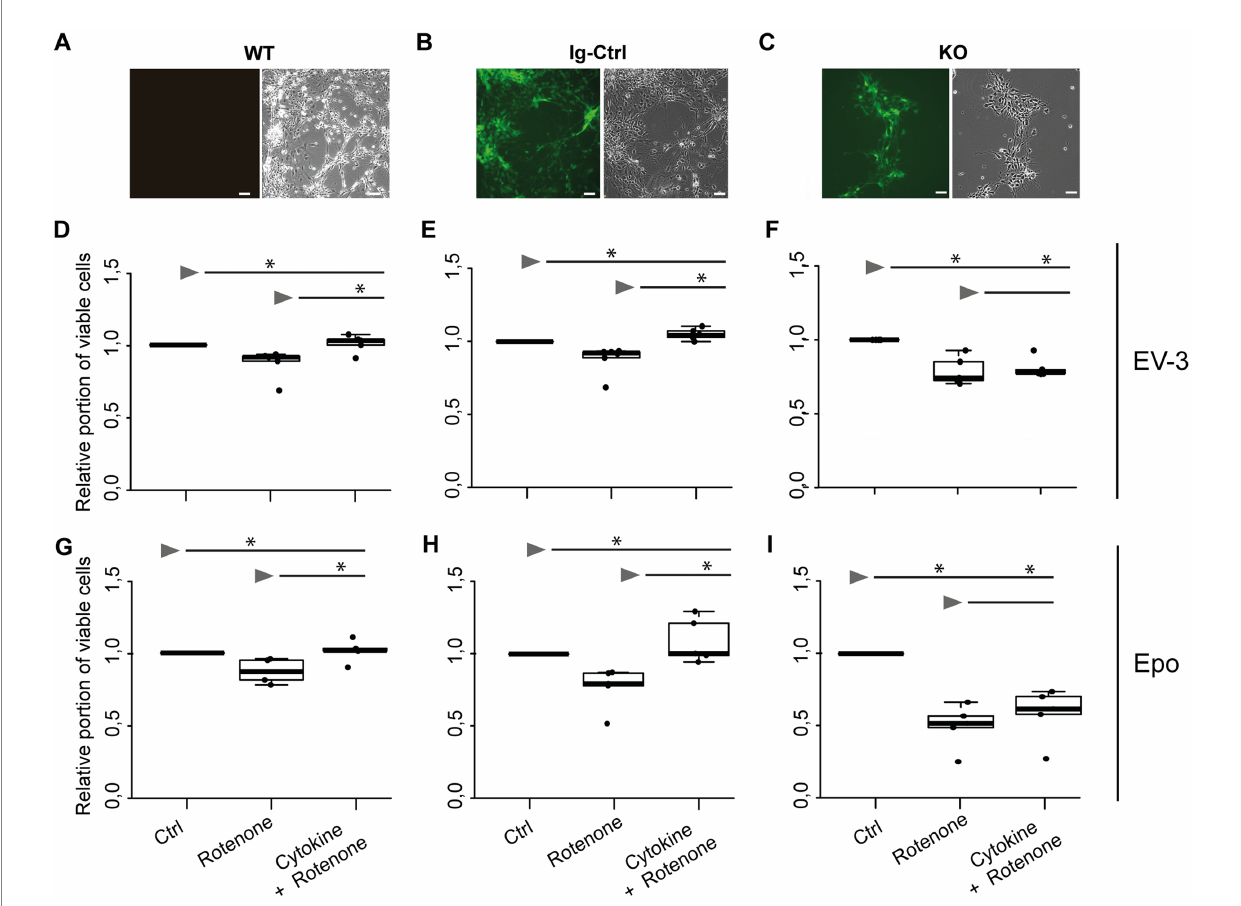
FIGURE 4 EV-3 and Epo induce CRLF3-mediated protection of human iPSC#2-derived neurons. Vertical panels depict data and images from WT (A,D,G) , isogenic controls (Ig-Ctrl) (B,E,H) , and CRLF3-mutated (KO) (C,F,I) iPSC-derived neurons. (A–C) Brightfield and fluorescent images of iPSC-derived neurons. Ig-Ctrl (B) and KO (C) cells display GFP fluorescence, indicating Cas9-GFP fuse transcript. (D–I) Relative survival of iPSC#2-derived neurons. Cells were prepared for FACS analysis by live/dead and ß-III-tubulin staining. (D–F) Data collected for neuron-like cells tested with EV-3. 18 h exposure to 1 μ M rotenone reduced the survival of WT (D) , Ig-Ctrl (E) , and KO (F) neurons significantly when normalized and compared to survival in respective untreated control cultures. Rotenone-induced cell death was prevented by EV-3 (33.3 ng/mL) in WT and Ig-Ctrl neurons but not in CRLF3-KO neurons. Treatment of Ig-Ctrl neurons to EV-3 significantly increased cell survival in comparison to control cells. n = 5 for WT and KO experiments, n = 6 for Ig-Ctrl. (G–I) Relative survival of iPSC#2-derived neurons treated with Epo. 1 μ M rotenone -induced cell death was prevented by 33.3 ng/ml Epo in WT (G) and Ig-Ctrl (H) cells. CRLF3-KO cells were not protected by Epo treatment. n = 5 for all. Data is presented as boxplots showing the median cell survival, upper and lower quartile and whiskers representing 1.5 x interquartile ranges. Single data points are shown as circles within the